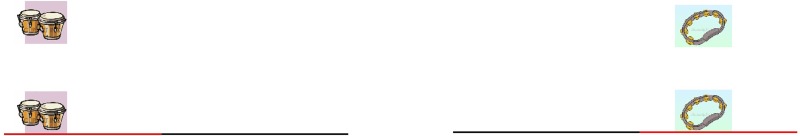
Visual stimuli of the percussion game.The left panel shows when the drum pattern hits the line, and the right panel shows when the bell pattern hits the line.